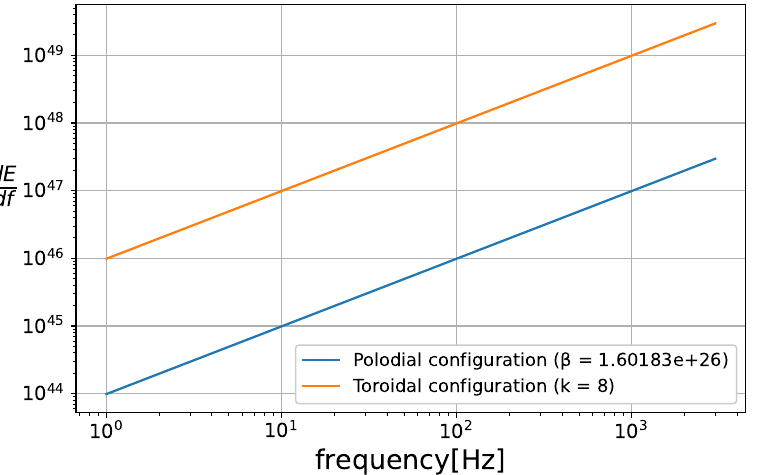
Figure 5. The expected evolution of the GW energy spectra emitted by the magnetars for different field configuration with frequency for a specific parameter’s space. Overall, the energy spectrum tends to increase rapidly as frequency increases. The orange and blue lines represent the results calculated by involving parameters I = 10 43 kg km 2 , R = 10 km, (cid:101) = 0.02. The predicted energy spectrum is less than the so far detected energy